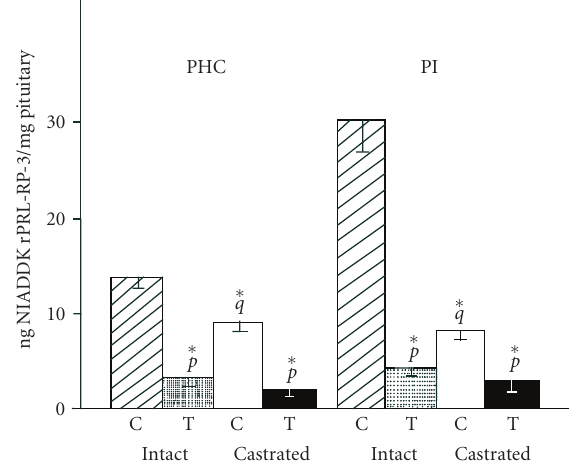
Figure 4: Intrapituitary contents of PRL after incubation of PHC (left-hand panel) and PI (right-hand panel) from normal rats without (stippled bars) or with (hatched bars) testosterone (0.3mM) or from castrated rats incubated without (open bars) or with (solid bars) testosterone (0.3mM) for 72 hours. Values represent mean ± SE derived from 10 pituitaries. p , q , r , denote significant di ff erences in groups incubated with or without testos- terone, normal controls versus castrated controls and between normal incubated with testosterone versus castrated incubated with testosterone, respectively. ∗ P ≤ . 05. C: Incubation without testosterone; T: Incubation with testosterone. Pituitary prolactin content was estimated by RIA in PBS homogenates of pituitary constructs incubated with or without 0.3 mM testosterone for 72 hours and a challenge dose of LHRH at 37 ◦ C for 4 hours [54].